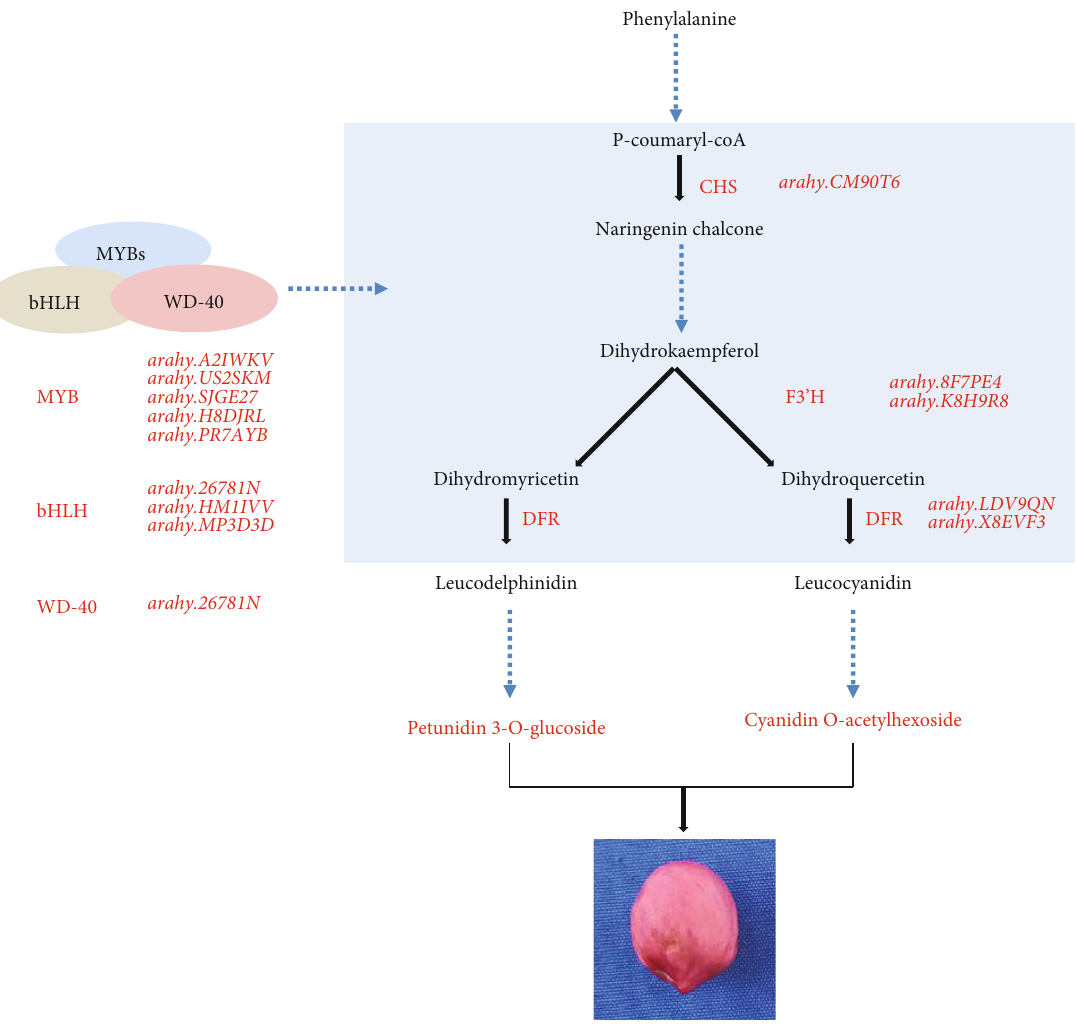
Figure 7: Prediction new model of red peanut testa formation. The red label indicated upregulated genes or metabolites. CHS: chalcone synthase; F3 ′ H: fl avanoid 3 ′ -hydroxylase; DFR: dihydro fl avonol